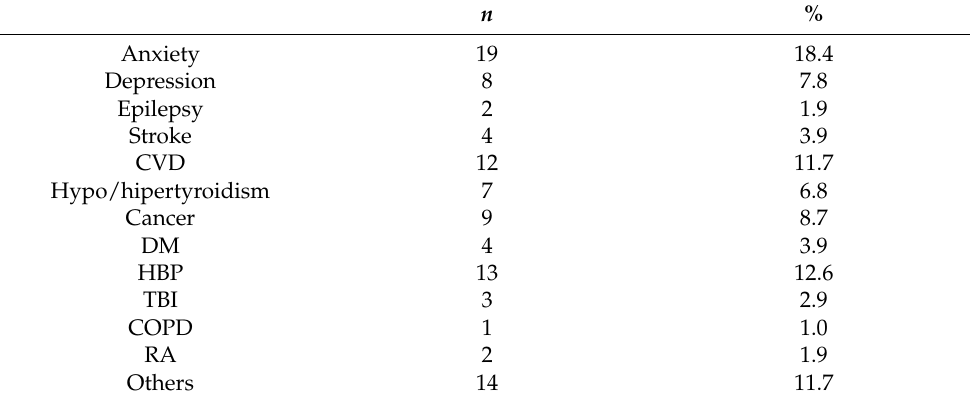
Table 2. Number (and %) of participants with medical history ( n = 103).